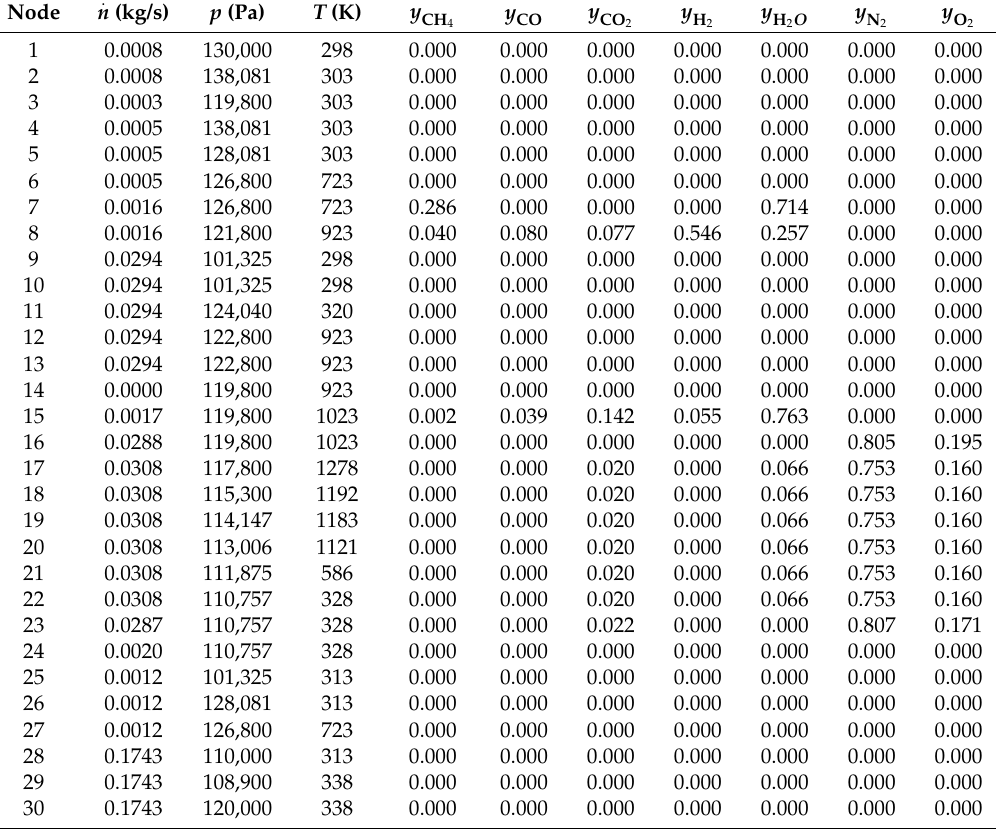
Table 5. Values for the thermophysical parameters of the proposed PV-SOFC hybrid system at full load conditions for the SOFC